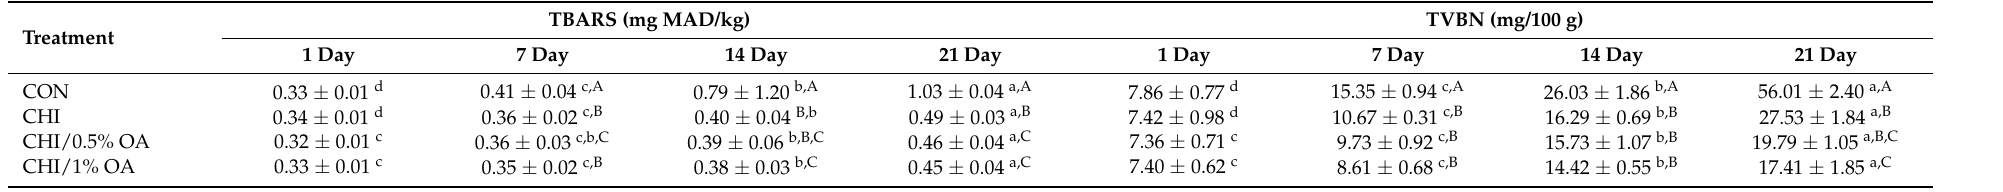
Table 3. TVBN and TBARS contents in coated pork during storage.